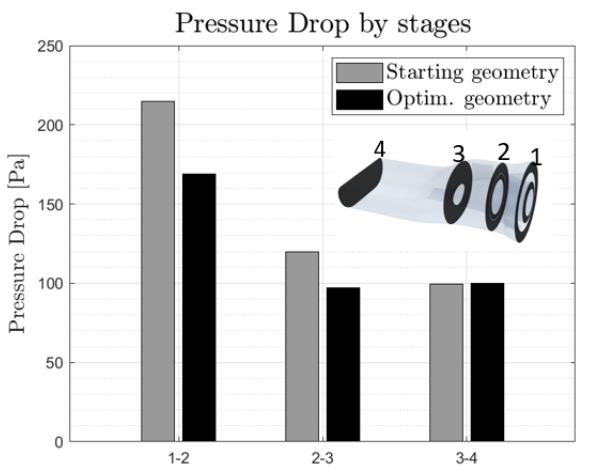
Figure 14. Pressure drop by stages along the x axis in the